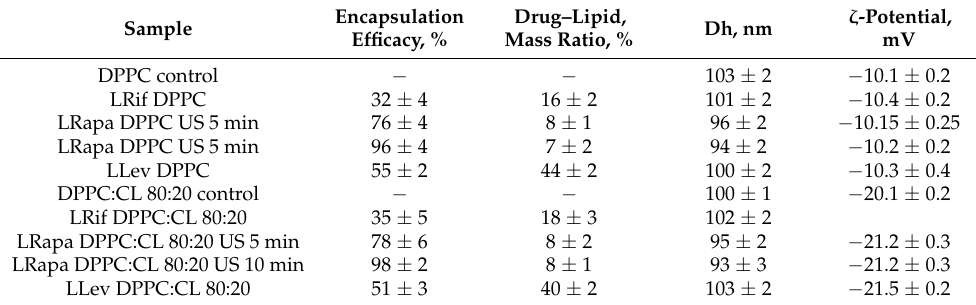
Table 1. Encapsulation efficacy, drug–lipid mass ratio (%), ζ -potential and hydrodynamic diameter of liposomal form of Rif, Lev and Rapa of various lipid compositions; 0,02 M Na-phosphate buffer solution, pH 7,4, 22 ◦